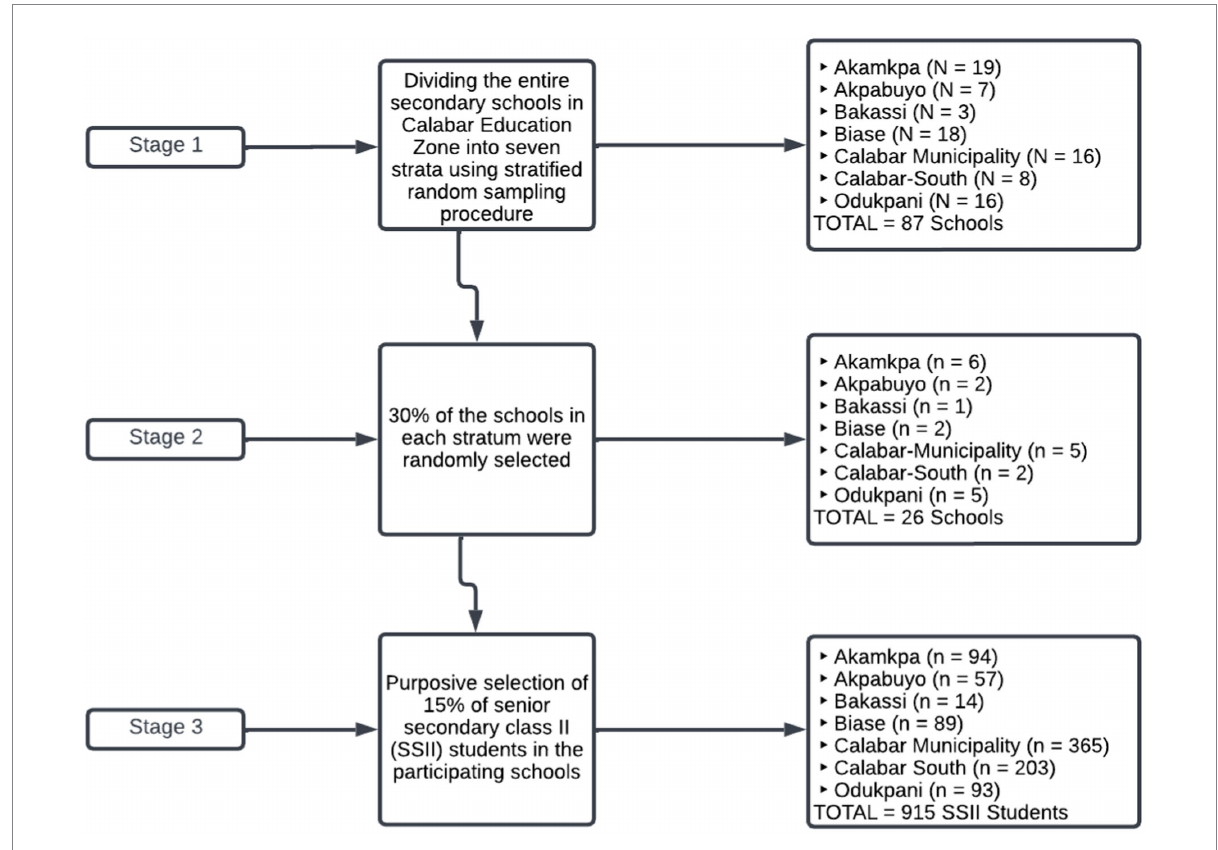
FIGURE 2 The multistage sampling procedure of this